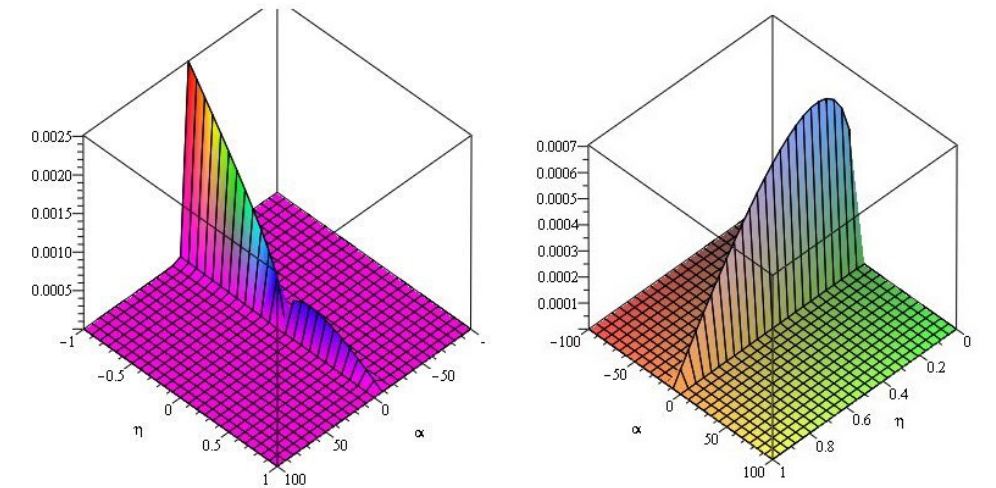
Figure 9. Error plot of µ ( α , η ) and ν ( α , η )